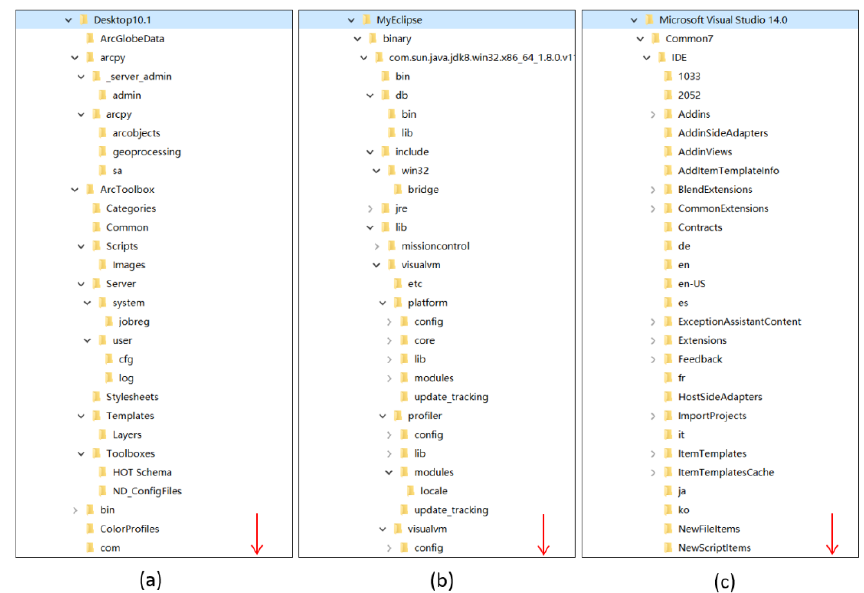
Figure 1. The data sources of the experiment: ( a ) ArcGIS Desktop 10.1 folder; ( b ) MyEclipse 2017 folder; ( c ) Visual Studio 2015 folder.